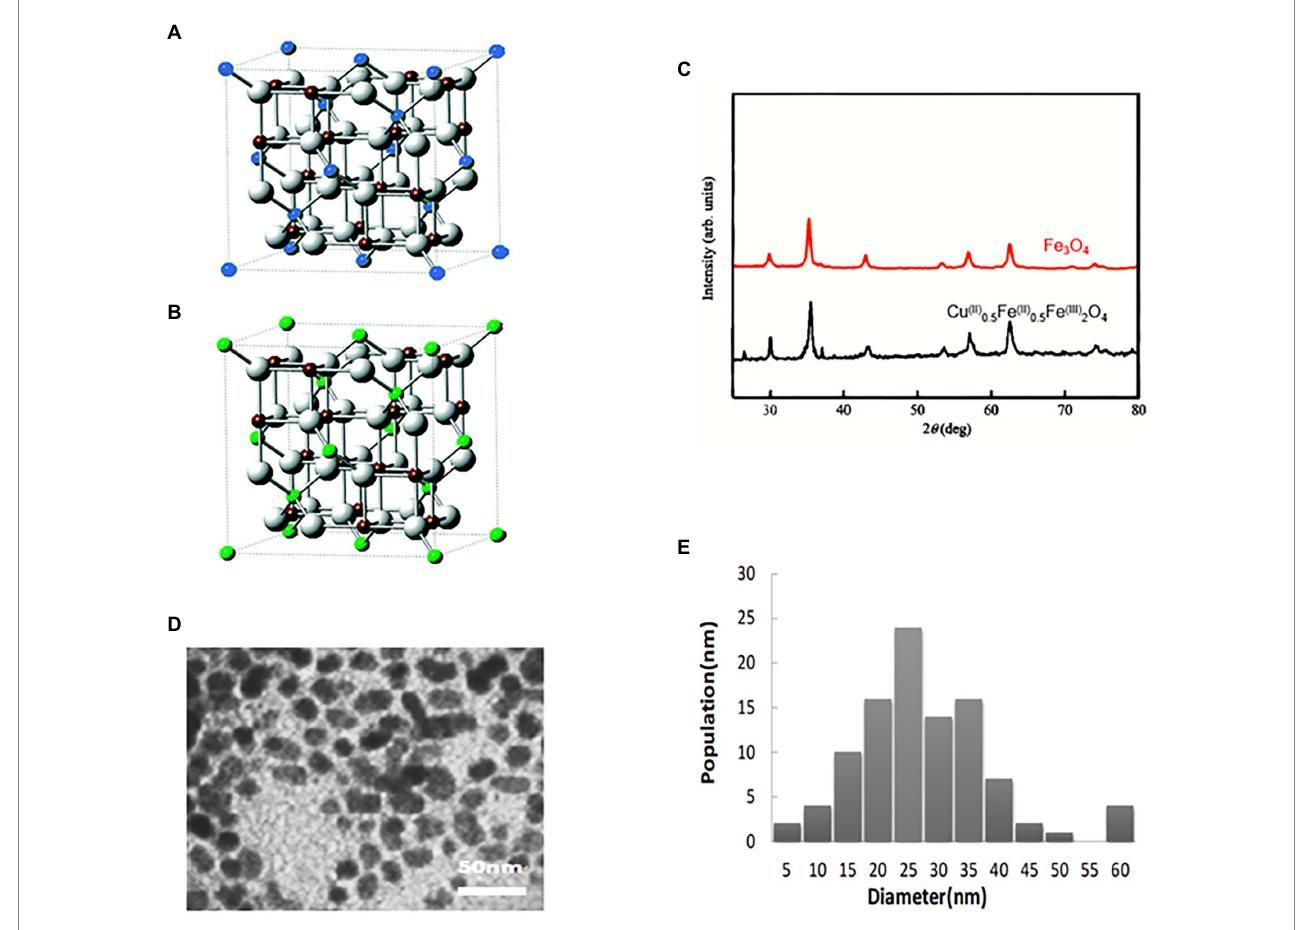
FIGURE 1 Characterization of Cu@Fe NPs. (A , B) 3D structures of Fe 3 O 4 NPs and Cu@Fe 3 O 4 NPs. Blue sphere: Fe 2+ ; Green sphere: Cu 2+ /Fe 2+ ; Brown sphere: Fe 3+ ; White sphere: O. (C) X-ray diffraction analysis (XRD) of Cu@Fe NPs. (D) Transmission electron microscopy (TEM) of Cu@Fe NPs. (E) Dynamic light scattering particle size (DLS) of Cu@Fe